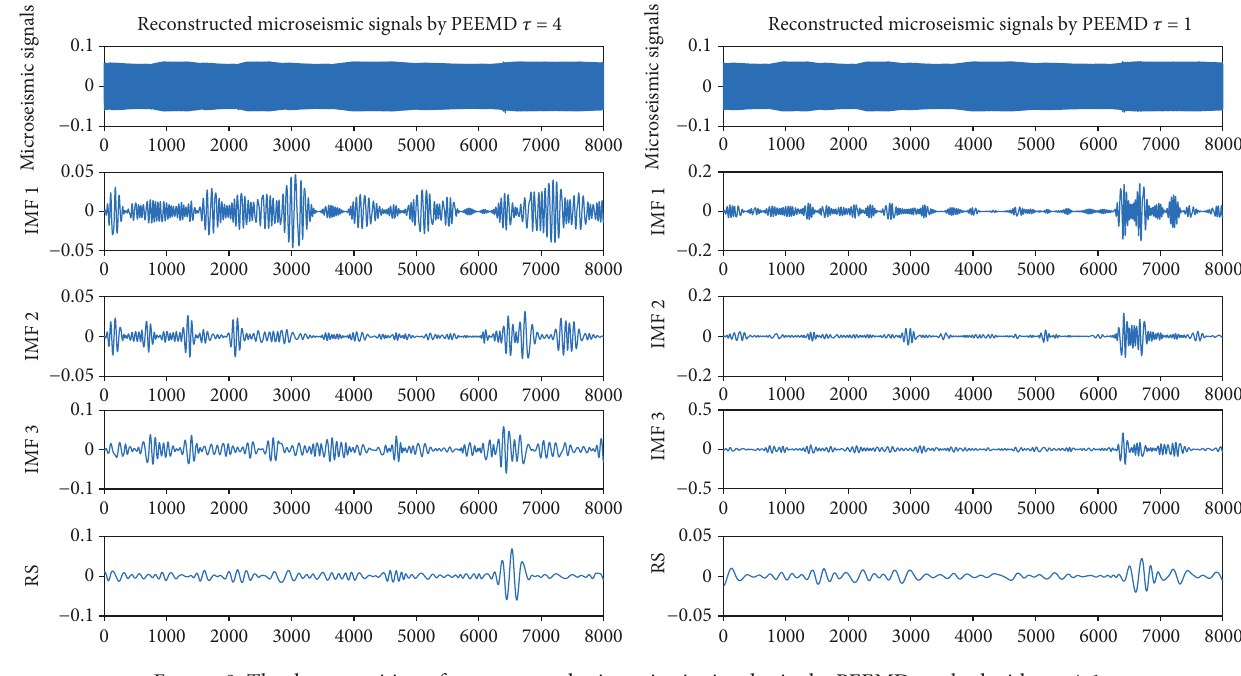
Figure 8: The decomposition of reconstructed microseismic signals via the PEEMD method with τ = 4, 1 .